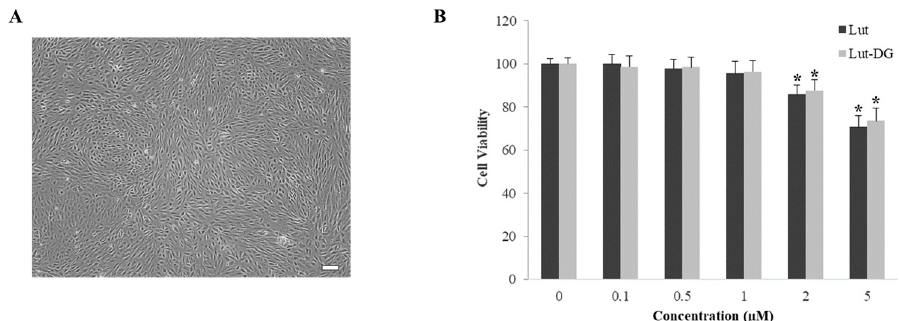
Figure 2. Effect of Lut and Lut-DG on cell viability of ARPE-19 cells. ( A ) Morphology by phase- contrast microscopy of ARPE-19 cells. Scale bar represents 100 µm; ( B ) ARPE-19 cells were treated with a concentration range (0.1–5 µM) of Lut and Lut-DG for 24 h, after which cell viability was measured using MTT assay. Graphs represent average cell viability (mean ± SD values, n = 4; (One-Way ANOVA test), * p ≤ 0.05 vs. control